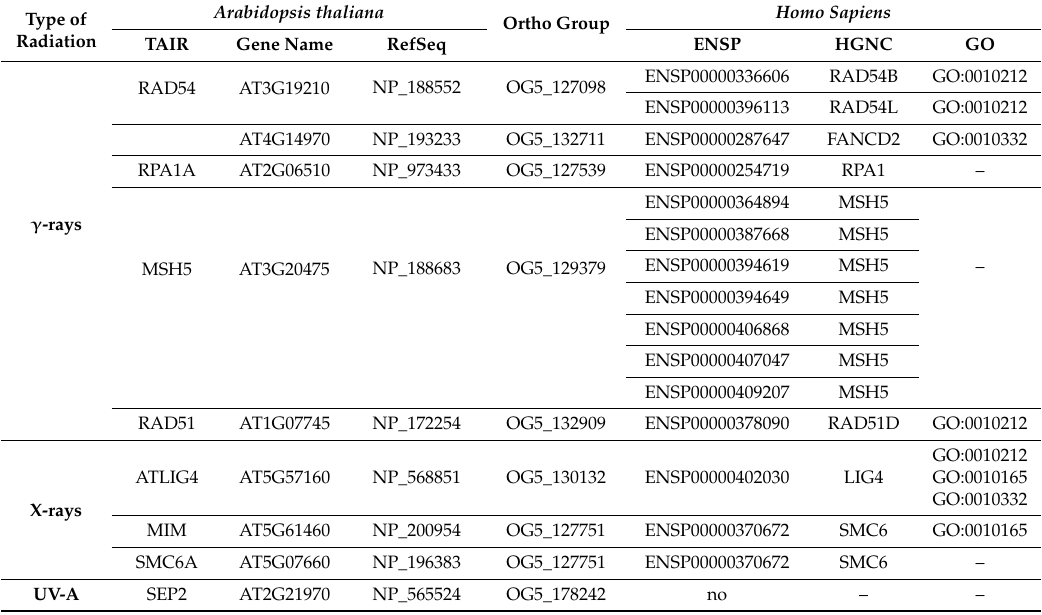
Table 3. Human orthologues of the resulting genes, proposed as exclusive biomarkers for the detection of the exposure to the several types of the electromagnetic